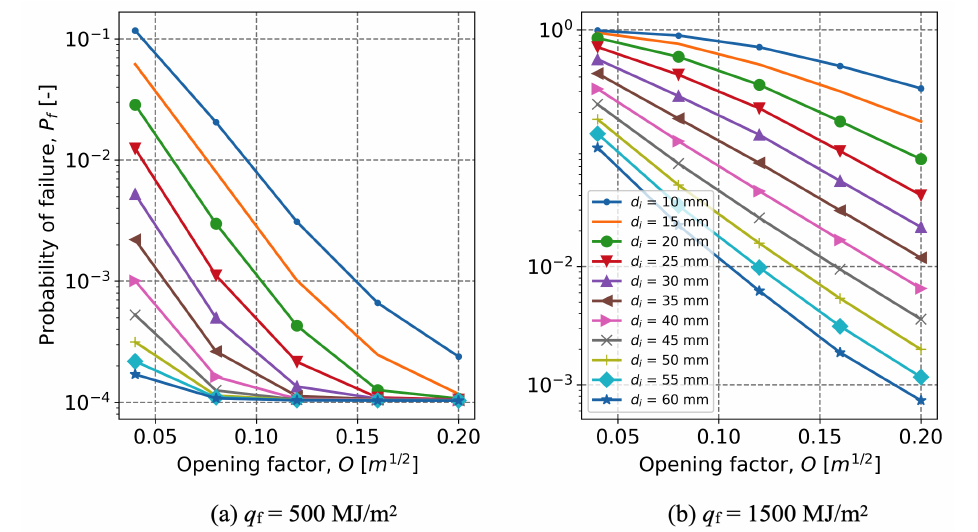
Figure 2. Fragility curves for steel columns with varying SFRM thickness under parametric fire exposure.